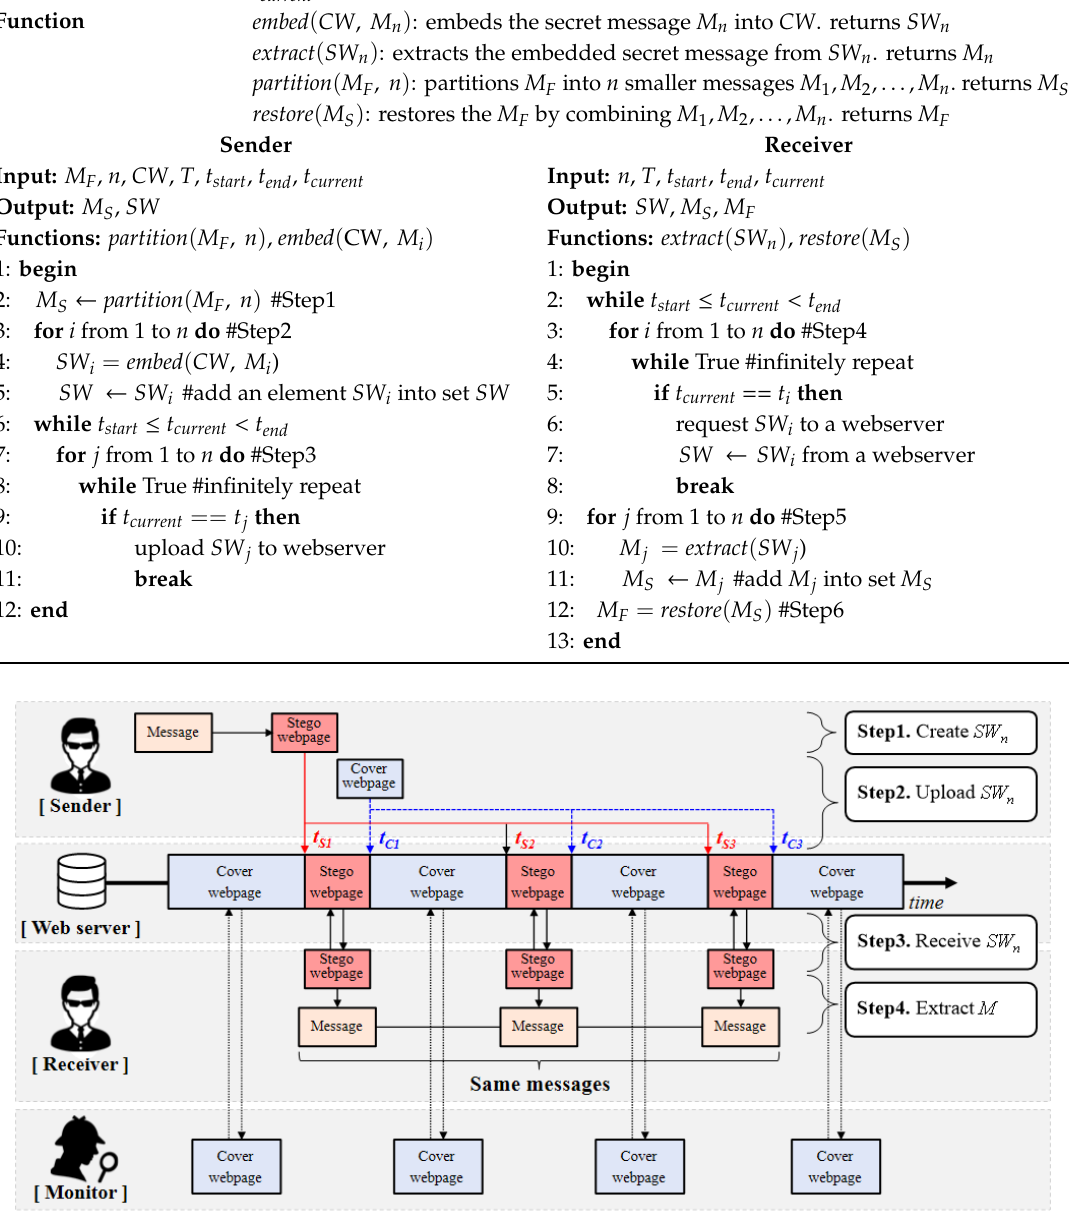
Figure 8. Working steps of Time-based Dynamic Operation Algorithm for Undetectability (TDOA- U). Algorithm 2 TDOA-U (Time-based Dynamic Operation Algorithm for Undetectability) Definition